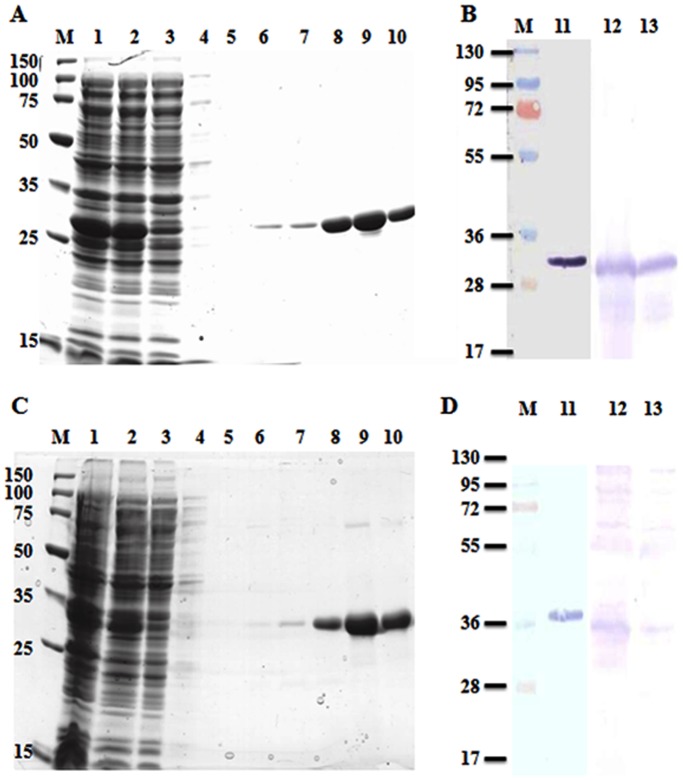
Purification of recombinant Cfd1 and Nbp35 protein.The recombinant Cfd1 protein was purified through Ni+2-NTA column. A) Lane M-marker, lane 1-total lysate, lane 2- supernatant, lane 3-flow through, lane 4-,5-, 6-, & 7- wash (10, 20, 35, & 50 mM imidazole), lane 8- eluate (100 mM imidazole), lane 9- eluate (200 mm imidazole), lane10- eluate (300 mM imidazole). B) Immunoblot was probed with anti-Cfd1 antibody. Lane M- represents molecular weight proteins marker, lane 11- purified rCfd1 protein was probed with anti-His monoclonal antibodies, lane 12- total E. histolytica cell lysate, and lane-13- supernatant of E. histolytica lysate C) Similarly, the recombinant Nbp35 protein was purified through Ni+2-NTA column Lane M-marker, lane 1- total lysate, lane 2- supernatant, lane 3- flow through, lane 4-,5-, 6-, & 7- wash (10, 20, 35, & 50 mM imidazole), lane 8- eluate (100 mM imidazole) lane 9- (200 mM imidazole), lane10- eluate (300 mM imidazole). D) Immunoblot was probed with anti-Nbp35 antibody. Lane M represents –molecular weight proteins marker, lane 11- purified rNbp35 protein was probed with anti-His monoclonal antibodies, lane 12- total E. histolytica cell lysate, and lane-13- supernatant of E. histolytica lysate.